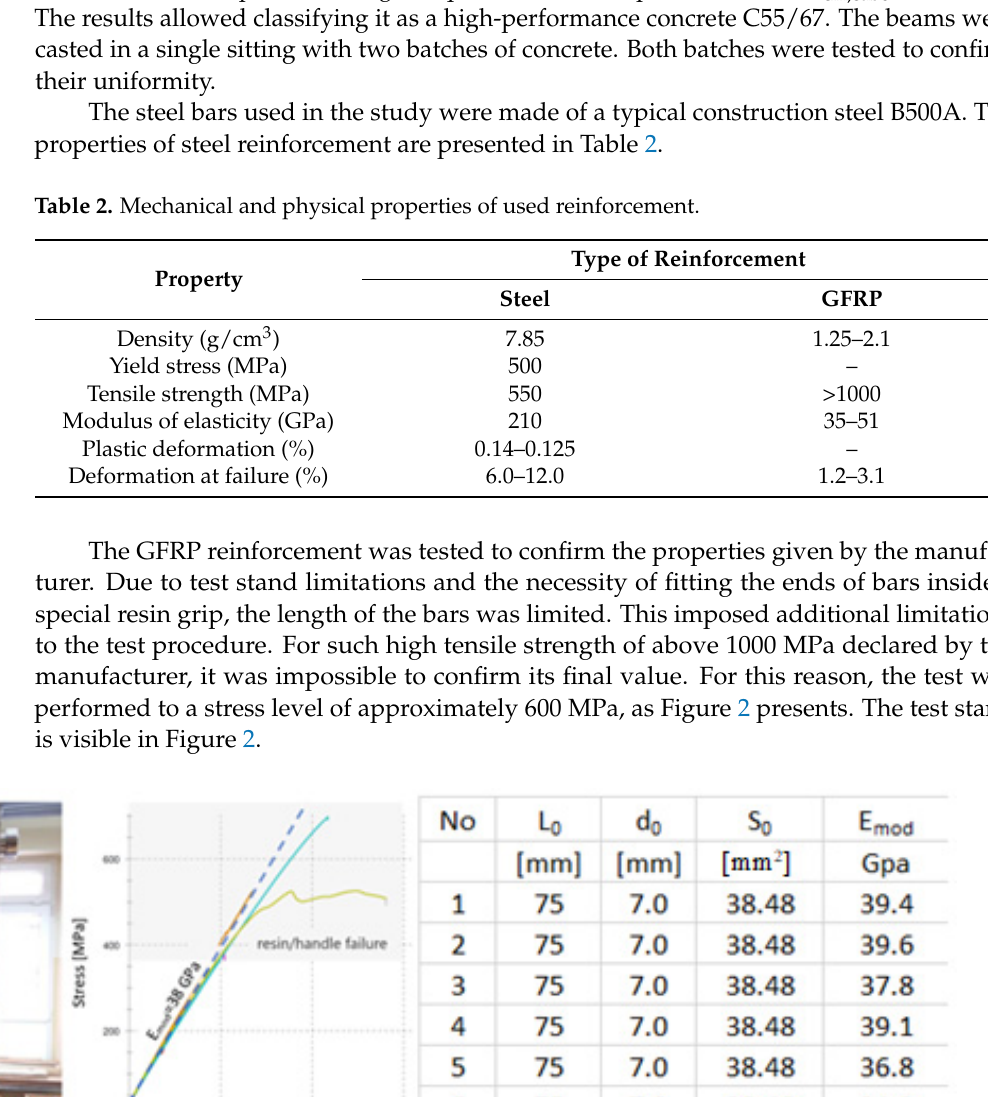
Table 1. The design of the mix used in the study.